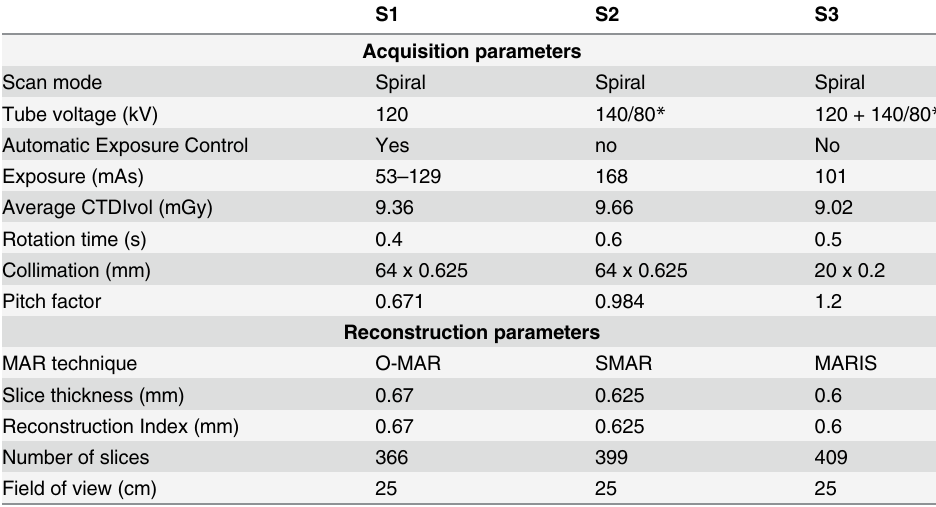
Table 1. Scan protocol for the CT scans of the three